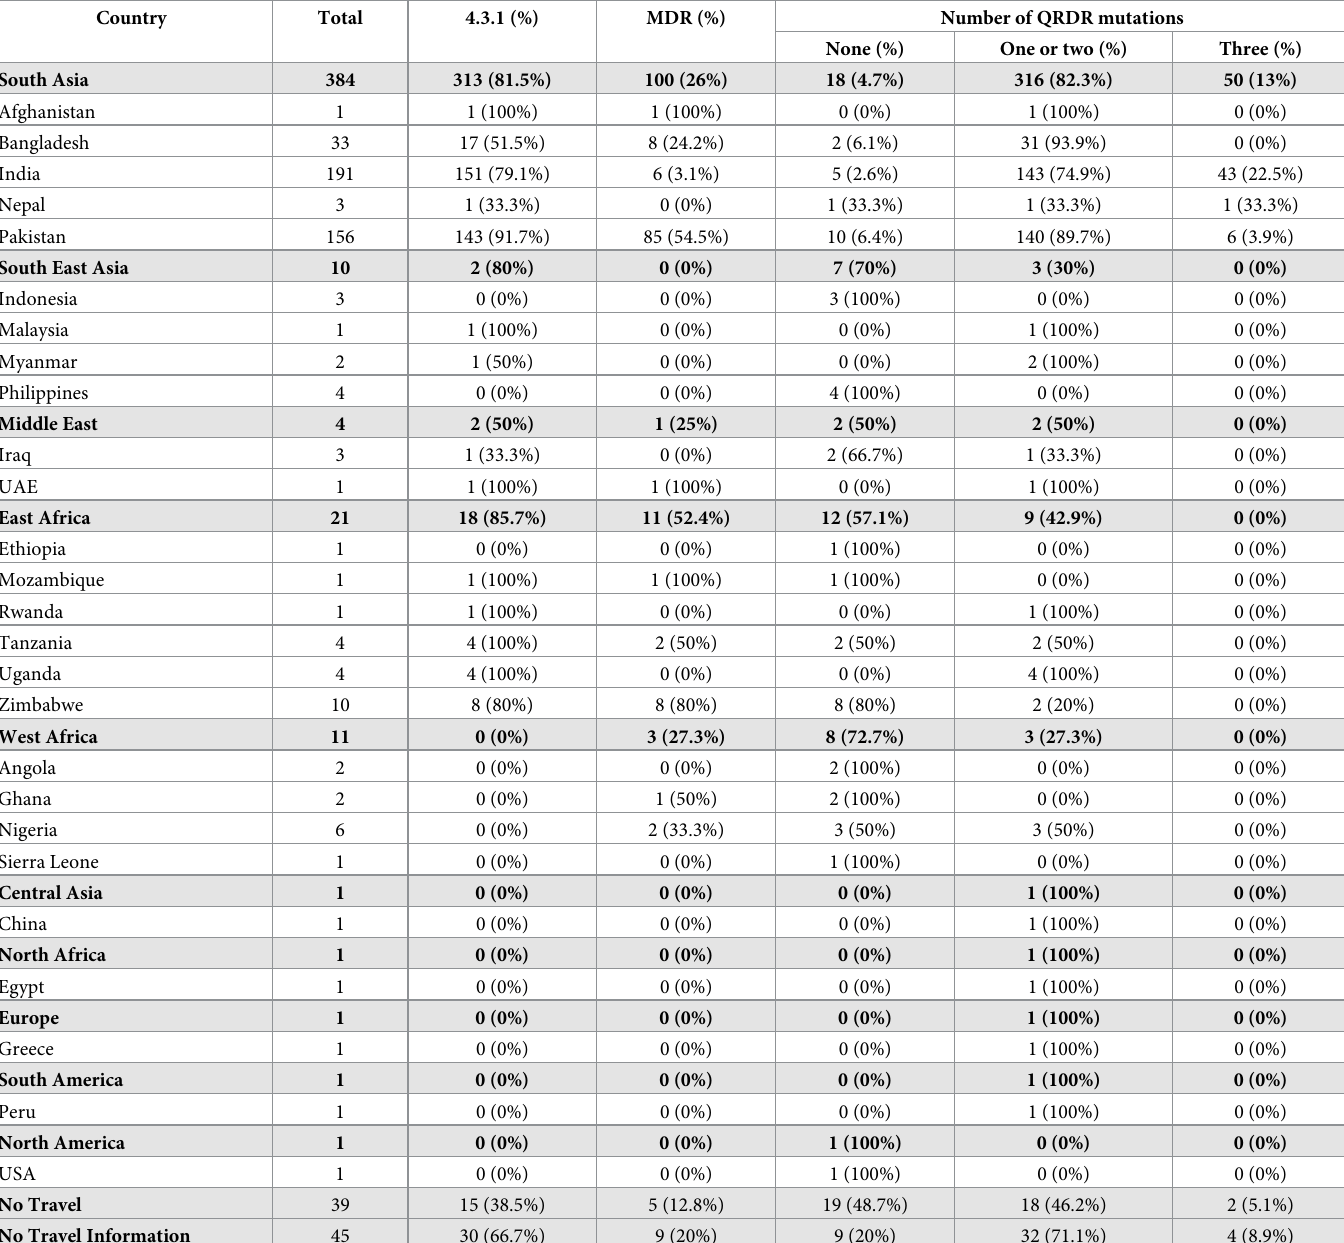
Table 1. Summary table of S . Typhi